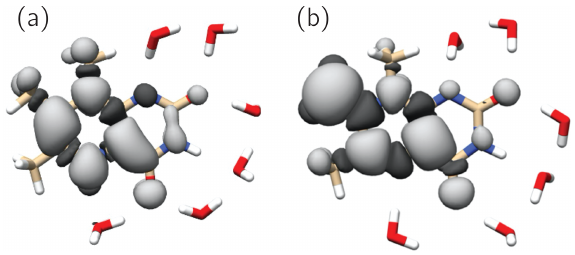
Figure 6. SOMOs of observed 6,7,8-trimethyllumazine radical species. Dark and light grey contours denote negative and posi- tive signs of the molecular wavefunctions. (a) TMLH red (cid:113) (b) TML ox